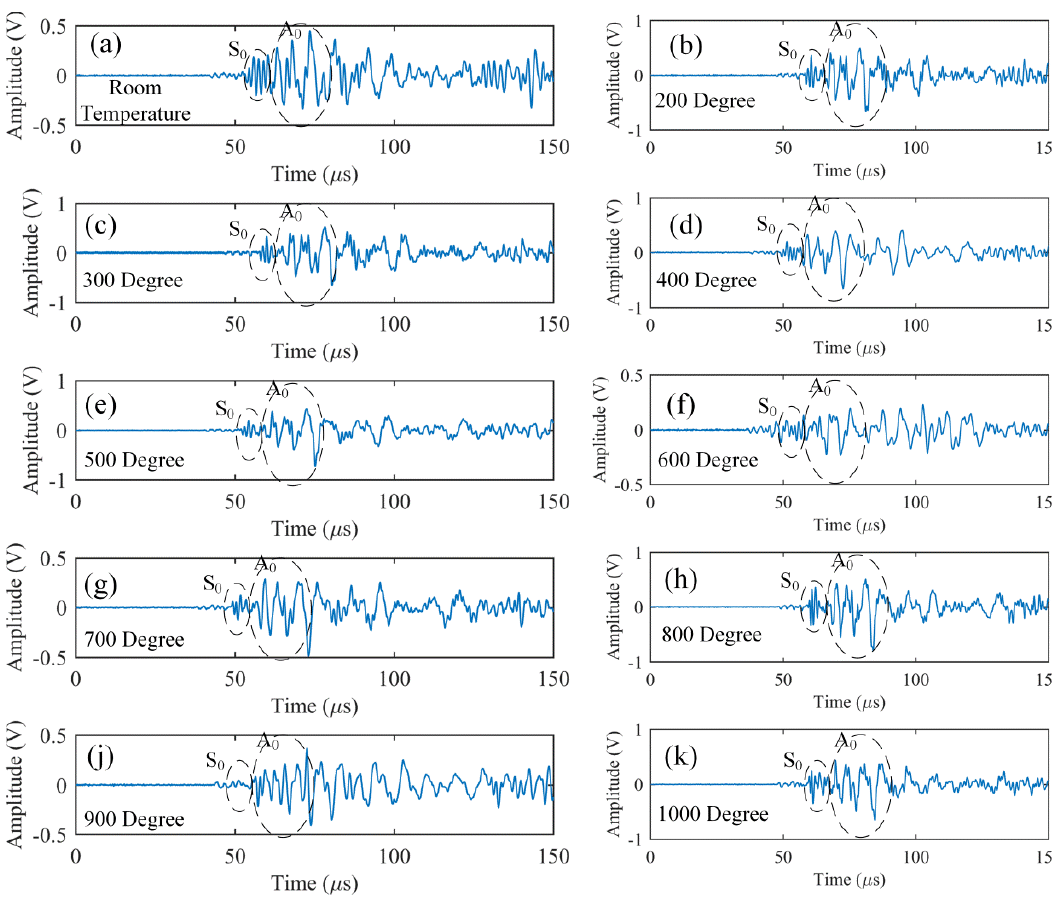
Figure 14. Responses of PSFBG sensor in the ADRM configuration to the simulated AEs at different high temperatures.